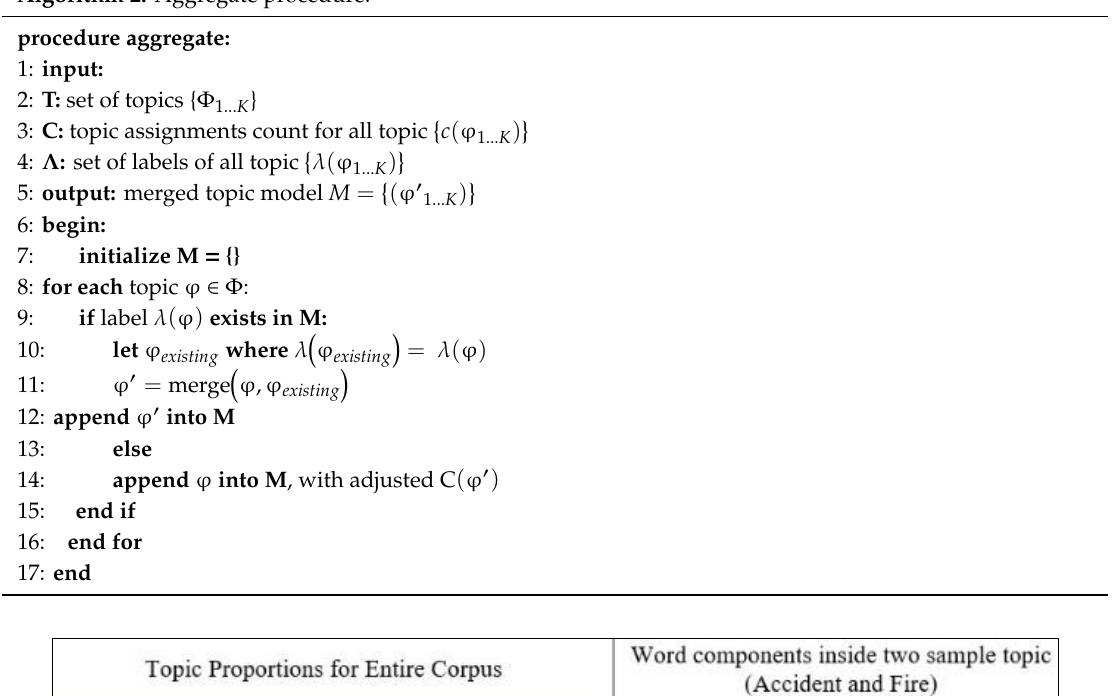
Algorithm 2. Aggregate procedure.